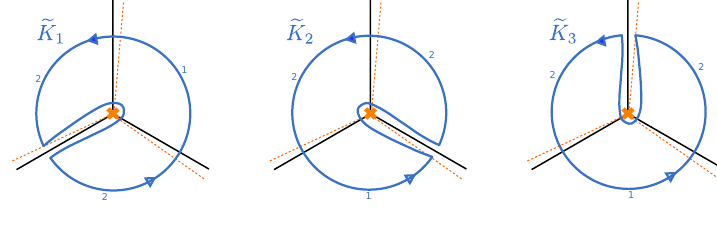
Figure 25 . Three lifts e K n of K .